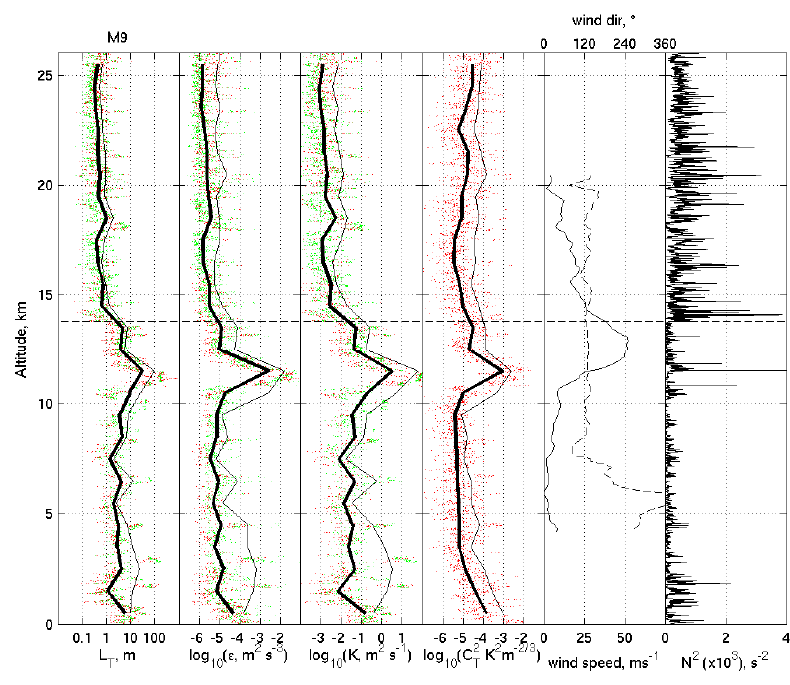
Fig. 7. Same as Fig. 5, but for flight Figure 7. Same as Figure 5, but for flight M9.